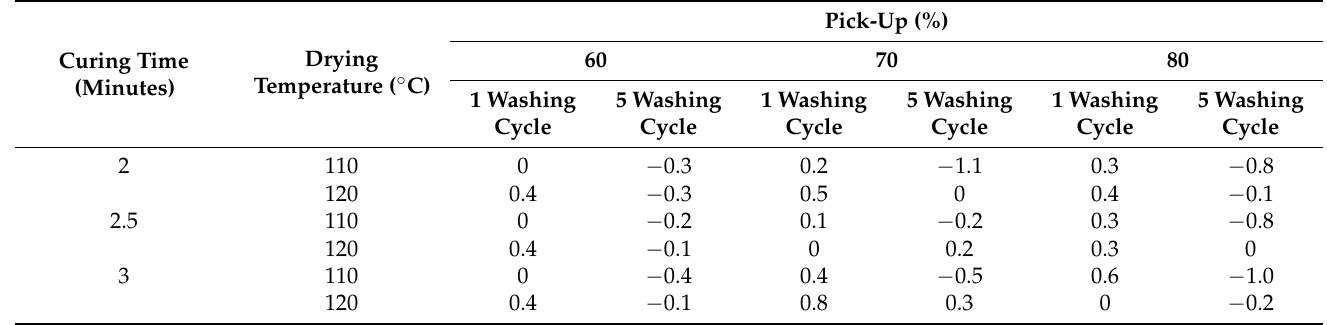
Table 9. Relationship between number of laundering, pick-up, drying time, curing time and percent- age of area change (%).